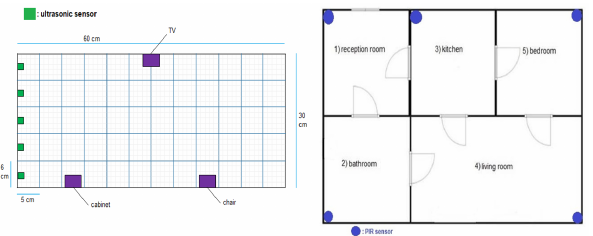
Figure 5. Prototype blueprint and living room ultrasonic sensor distribution.